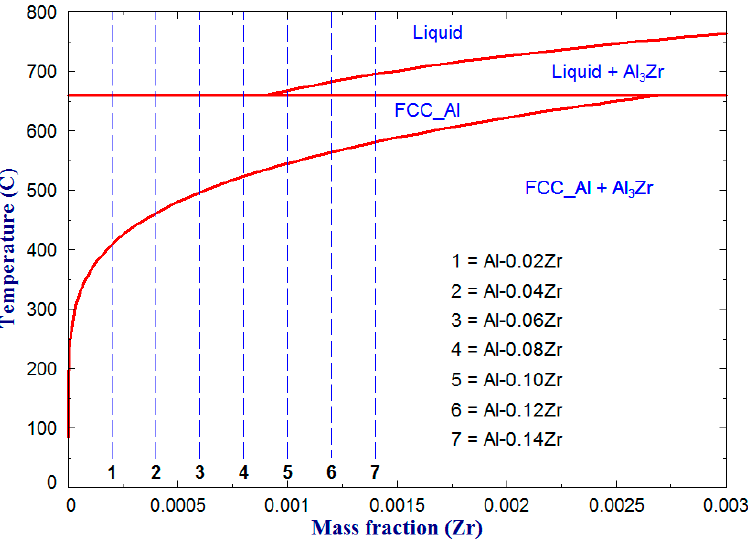
Figure 3. The calculated Al-rich side of the Al-Zr binary phase